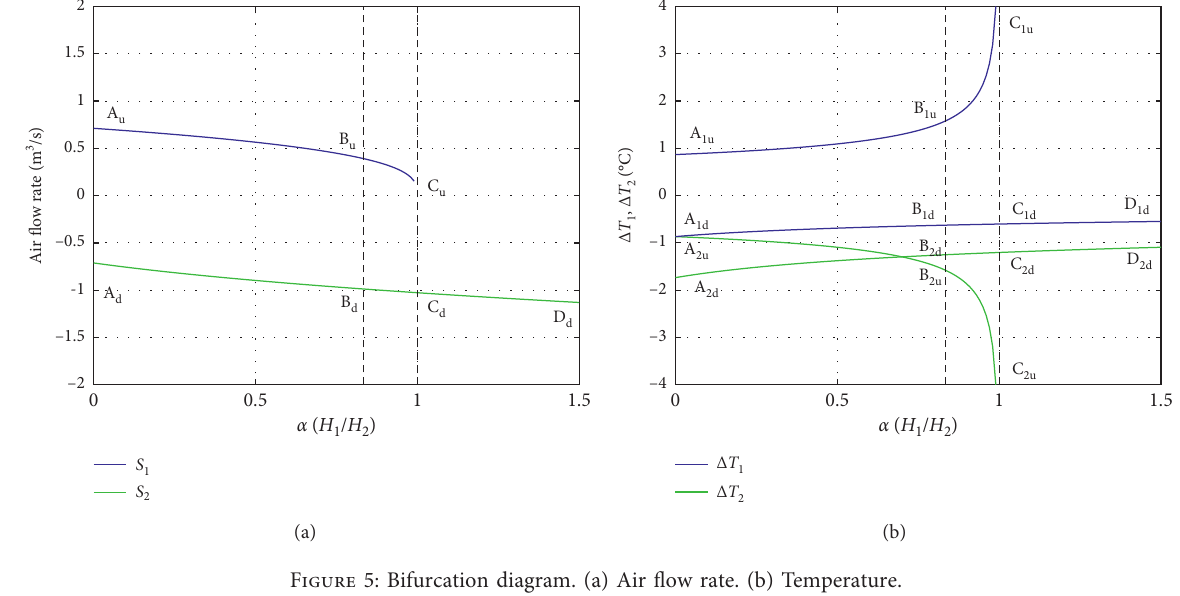
Figure 5: Bifurcation diagram. (a) Air flow rate. (b)